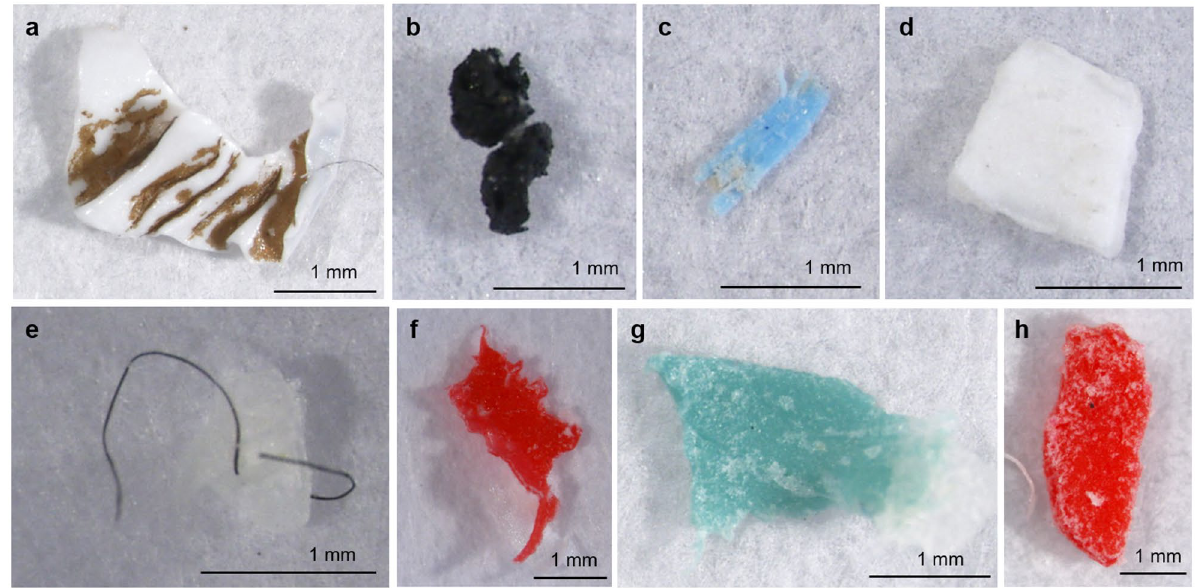
Figure 1. Examples of microplastics particles (colour, polymer composition and shape) found in angling baits (category, G = groundbait and B = boilies, and product, 1–6): ( a ) white polypropylene fragment (B6); ( b ) black additive fragment (G1); ( c ) blue polyethylene fragment (B2); ( d ) white additive fragment (B2); ( e ) black additive fibre (G1); ( f ) red polyethylene fragment (G2); ( g ) blue polyethylene fragment (G6) and ( h ) red polyethylene fragment